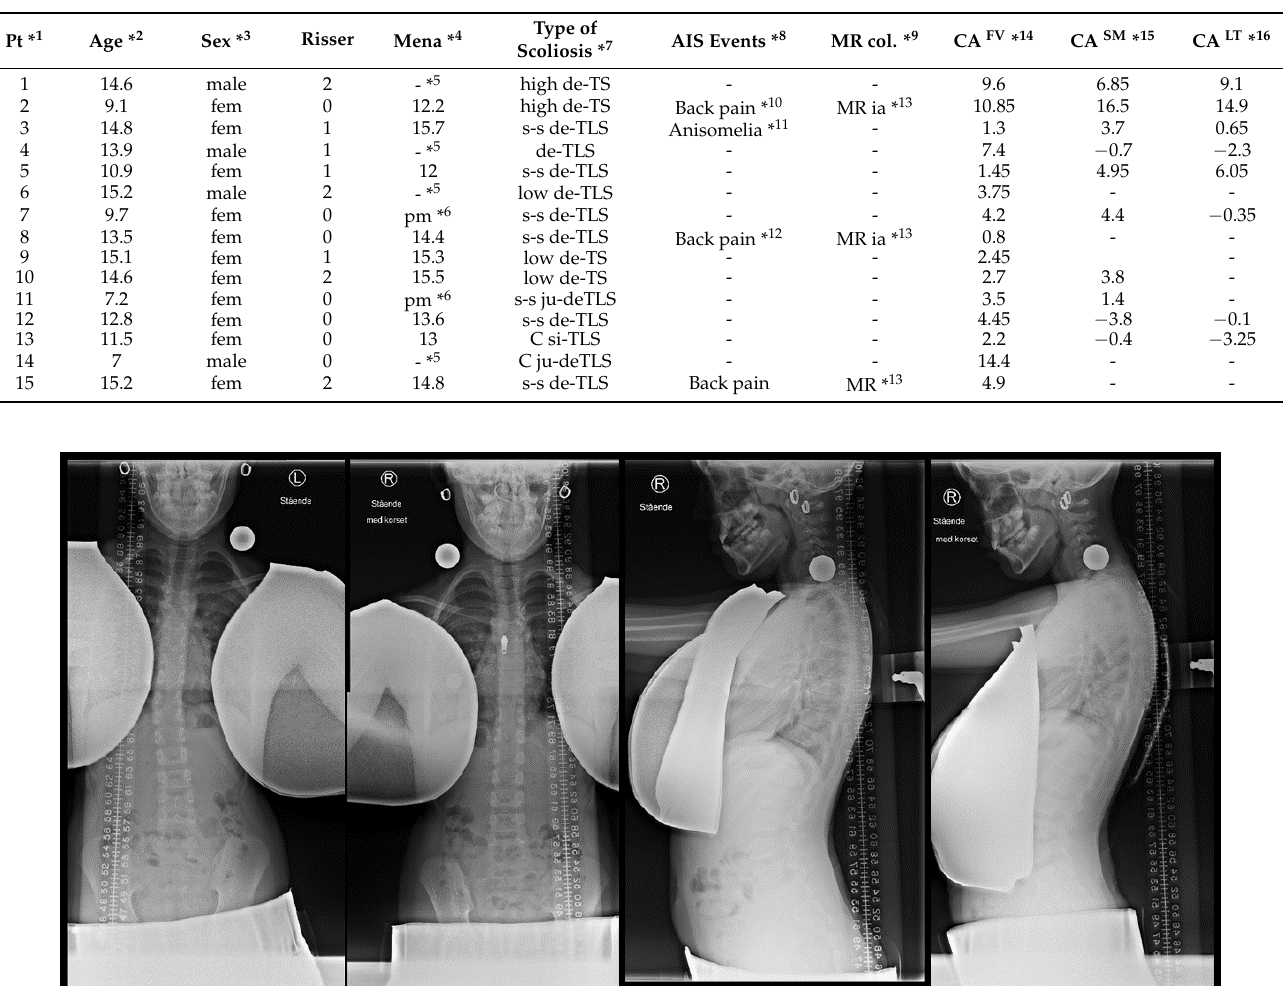
Figure 4. In-brace (picture two and four from left) and out-of-brace (picture one and three from left) of the frontal and sagittal radiographic examinations of a 10-year-old girl. The brace can be identified by the zipper at chest level in picture two and the ‘fingers’ are seen in picture four.